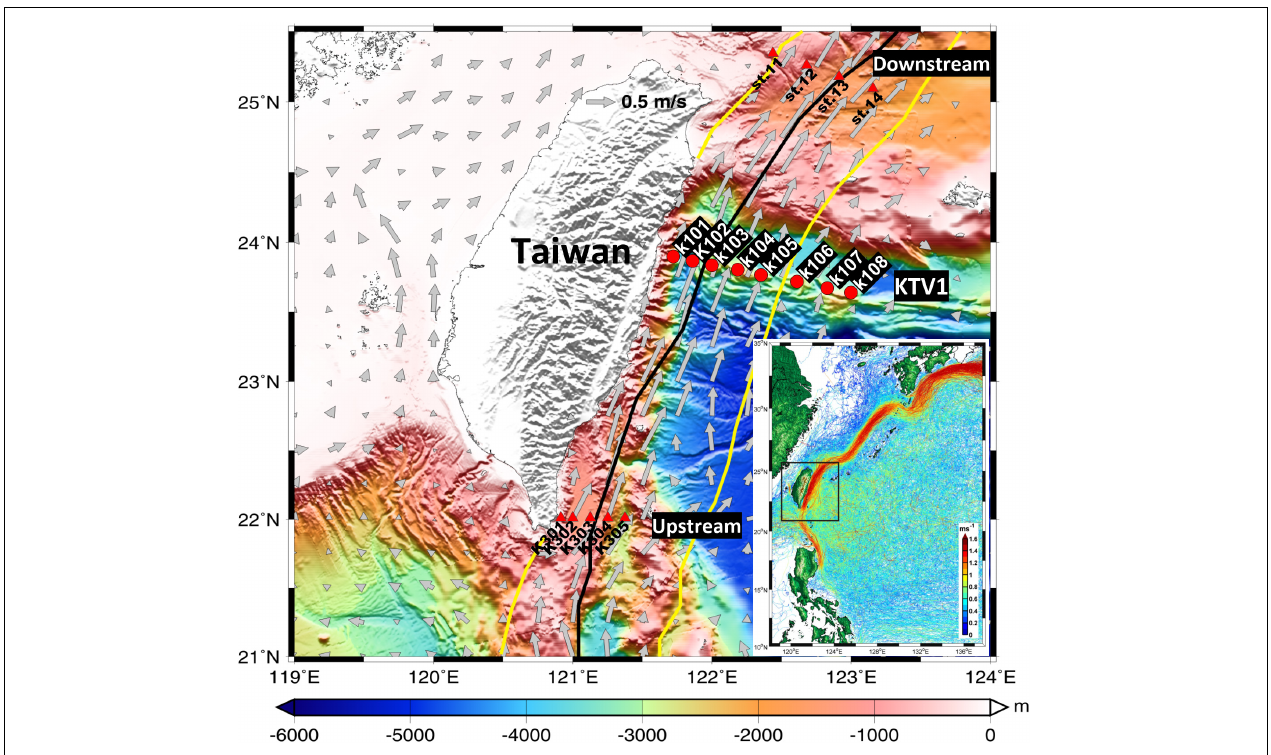
FIGURE 1 | Sampling stations (K101–K108) along the KTV1 transect of the Kuroshio, east of Taiwan. The climatological current velocity (gray arrows) at a depth of 30 m was computed from the historical ADCP dataset available from Taiwan’s Ocean Data Bank. The bold black line indicates the maximum velocity axis at 15 m depth obtained from the surface drifter data. The solid yellow line indicates the 0.2 m s − 1 isotach at 30 m depth obtained from the historical ADCP dataset (Jan et al., 2015). The path of the Kuroshio with velocity > 1 m s − 1 is indicated by surface drifter trajectories and speeds (data available at http://www.coriolis.eu.org/Data-Products/Data-Delivery/Data-selection) in the lower right inset where the black dotted rectangle marks the map area.